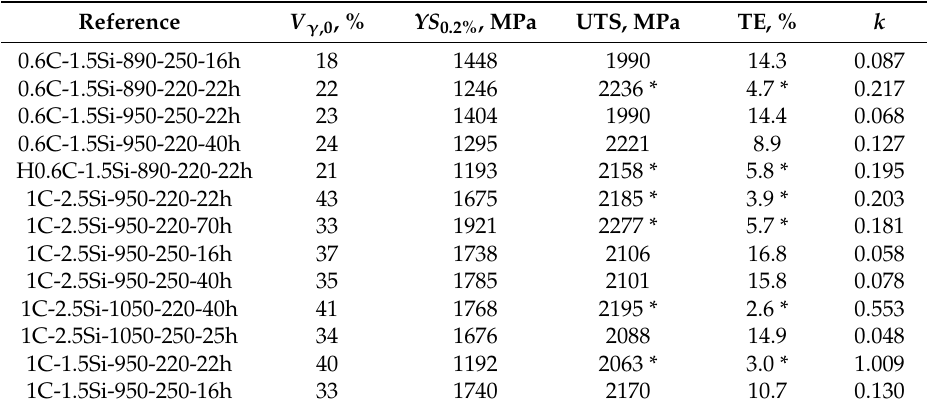
Table 3. Initial retained austenite content and tensile properties for all conditions investigated. The notation for the reference is explained in the text. * indicate brittle behaviour with no true UTS value and variable maximum elongation (the highest value of all tests is then given).